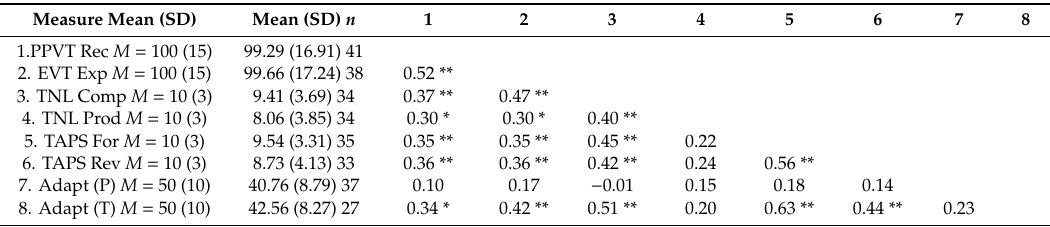
Table 4. Kendall’s tau-b correlations for vocabulary (Peabody Picture Vocabulary Test (PPVT) and Expressive Vocabulary Test (EVT)), narrative language (Test of Narrative Language-comprehension (TNL-C) and Test of Narrative Language-production (TNL-P)), and auditory memory measures (Test of Auditory Processing Skills (TAPS)-F and TAPS-R) with parent (P) and teacher (T) ratings on the BASC-3 Adaptive Skills composite